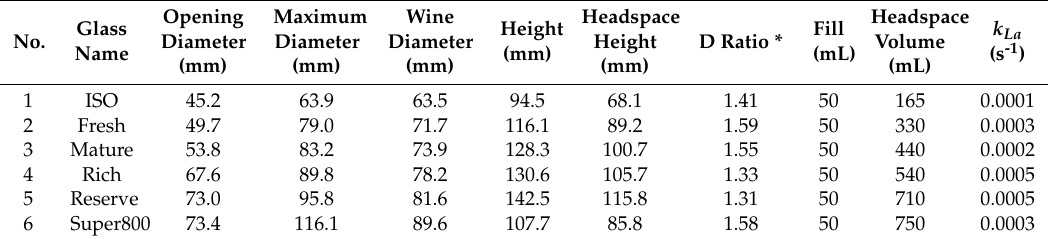
Table 1. Glass shape parameters, sample volumes and mass transfer coefficient ( k La ) for dissolved oxygen trials.